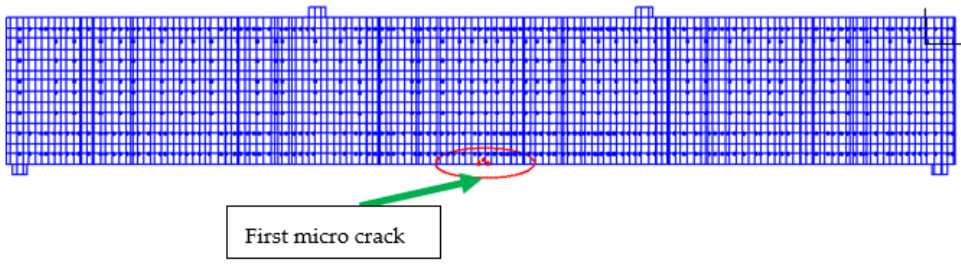
Figure 12. First cracks of specimen S0.